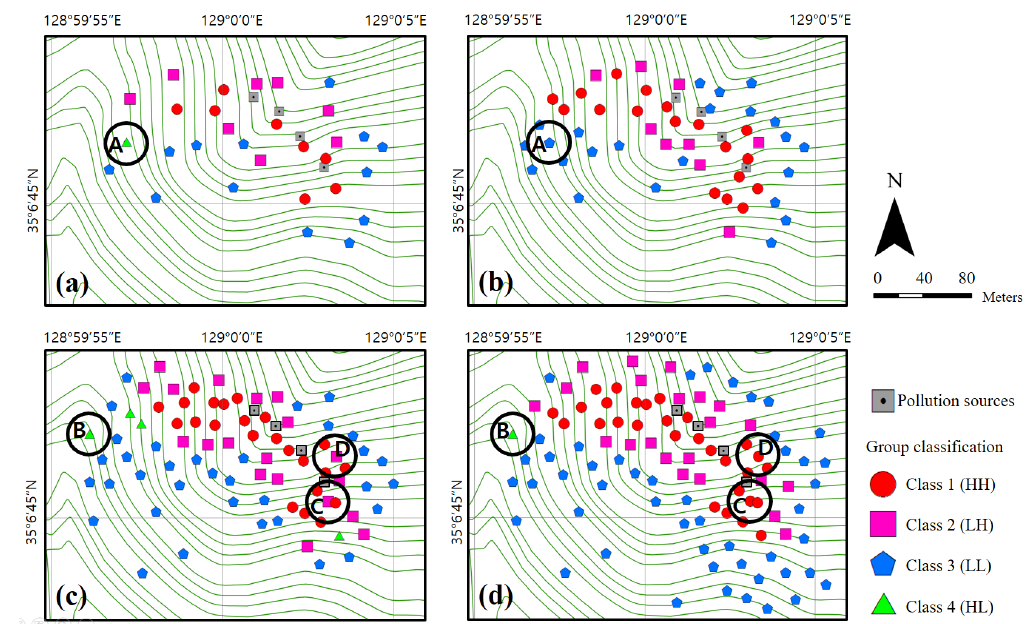
Figure 8. Classified sample distribution maps for each phase: ( a – d ) Phases 1–4, respectively. Samples A and B were estimated to be erroneous and a re-investigation was conducted for those sampling points.